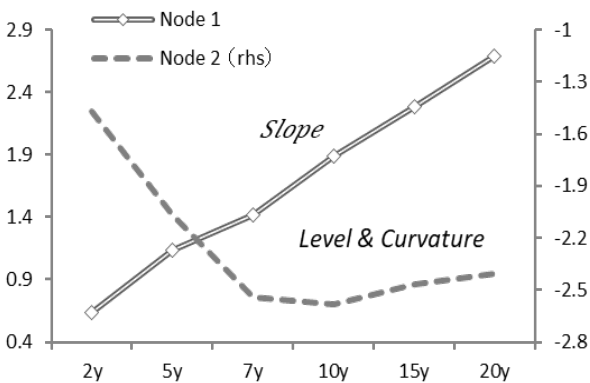
Figure 9. Coefficients of the linear function output from the hidden layer with two nodes.